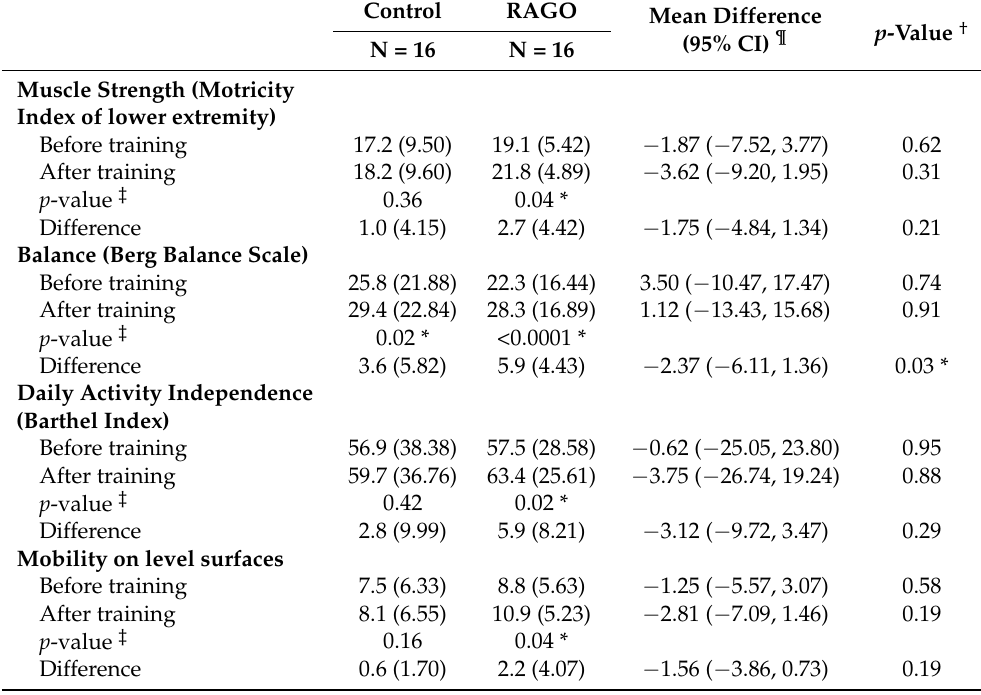
Table 2. Functional Outcomes Before and After